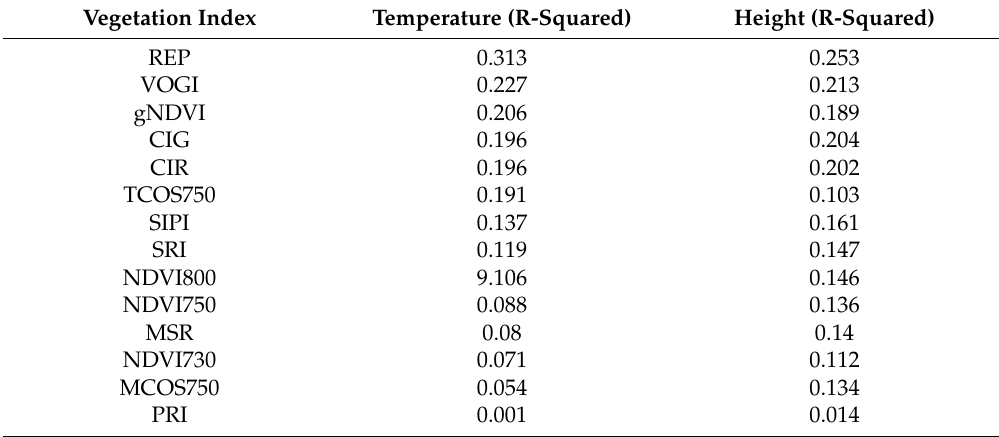
Table A2. Results of R-squared analysis of the vegetation indices contained in Table A1 and their relations to temperature and